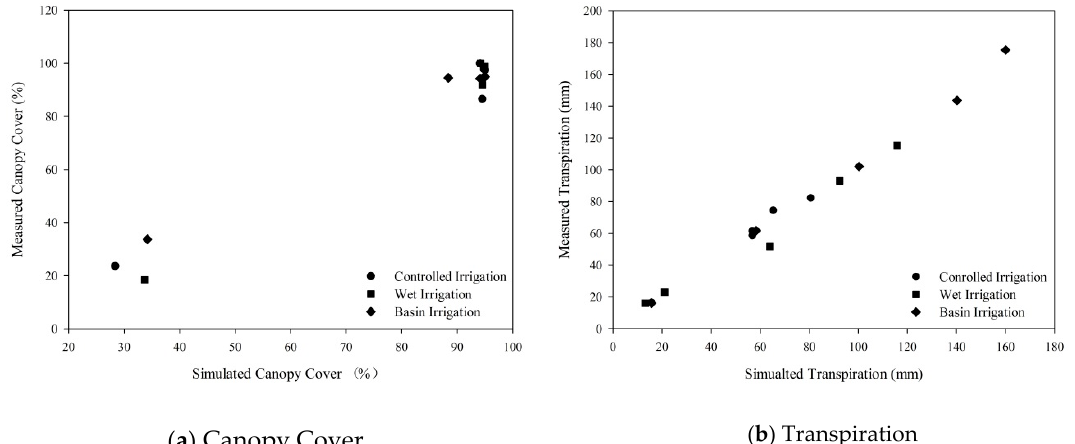
Figure 3. Model simulation result.